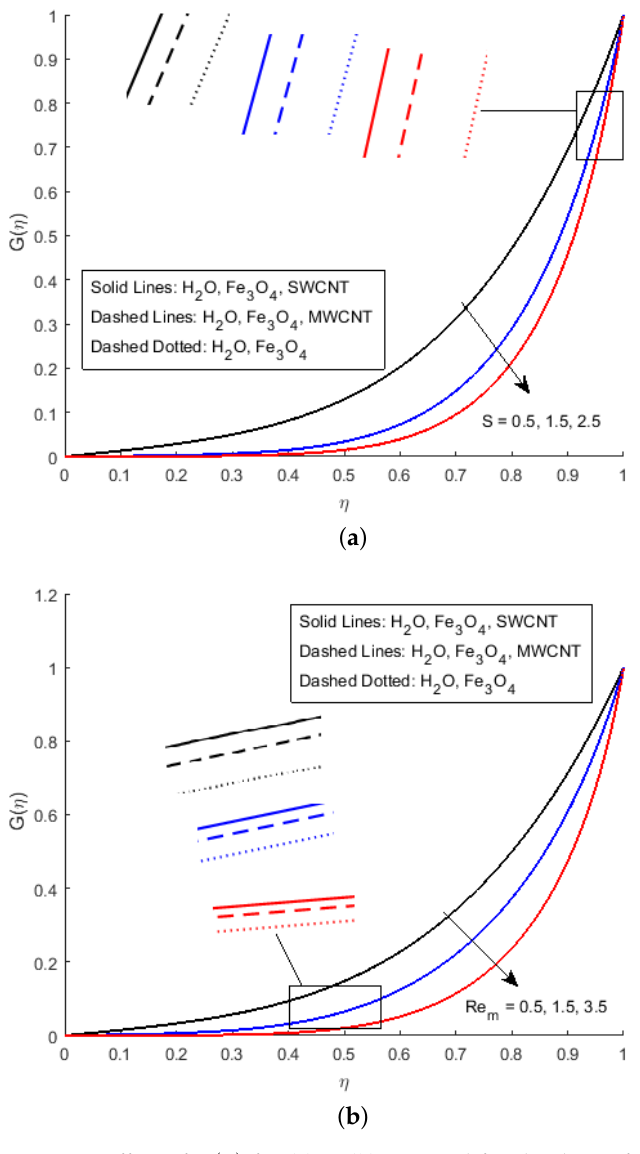
Figure 5. Effect of G ( η ) for ( a ) S , ( b ) Re m and fixed values of Ha = 1.4, Pr = 6.2, Ec = 0.5, δ = 0.4, Φ 1 = 0.02, Φ 2 = 0.5, m =